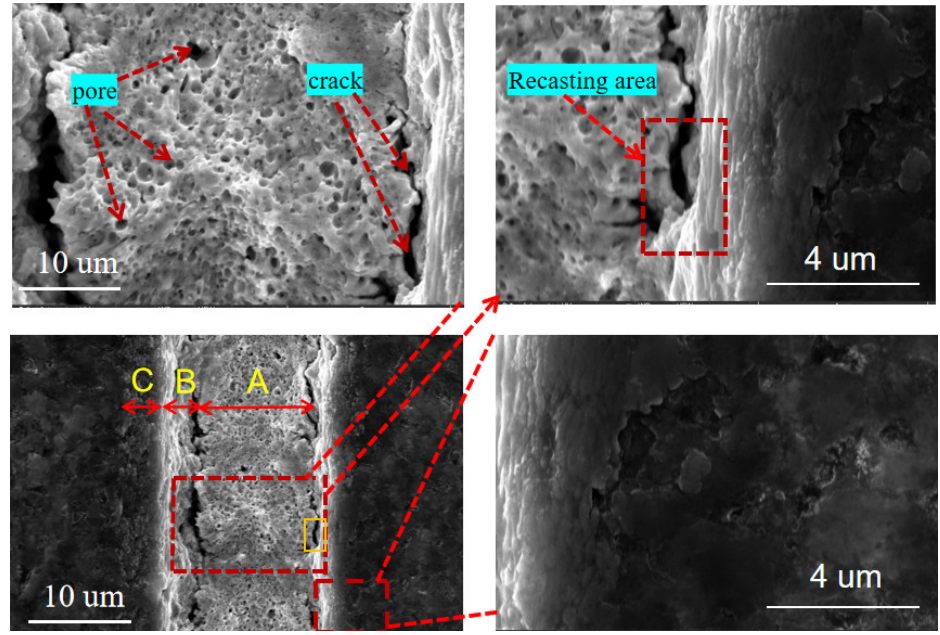
Figure 4. SEM image of microgroove texture on TiAlN-coated tool surface.